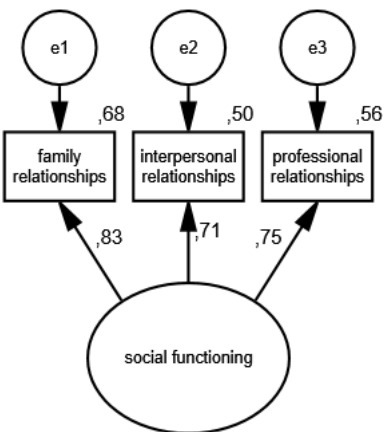
Figure 7. Standardized effects of the measurement model of social functioning in the group of women .